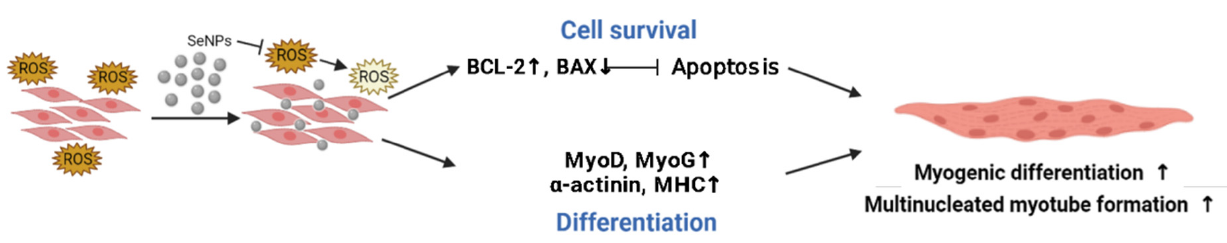
Figure 8. Schematic diagram of C2C12 cells cultured and treated with SeNPs for myogenic differentiation. SeNPs treatment protects cells from ROS (orange is higher ROS; yellow is lower ROS), thereby increasing cell viability and promoting cell differentiation, contributing to multinucleated myotube formation.